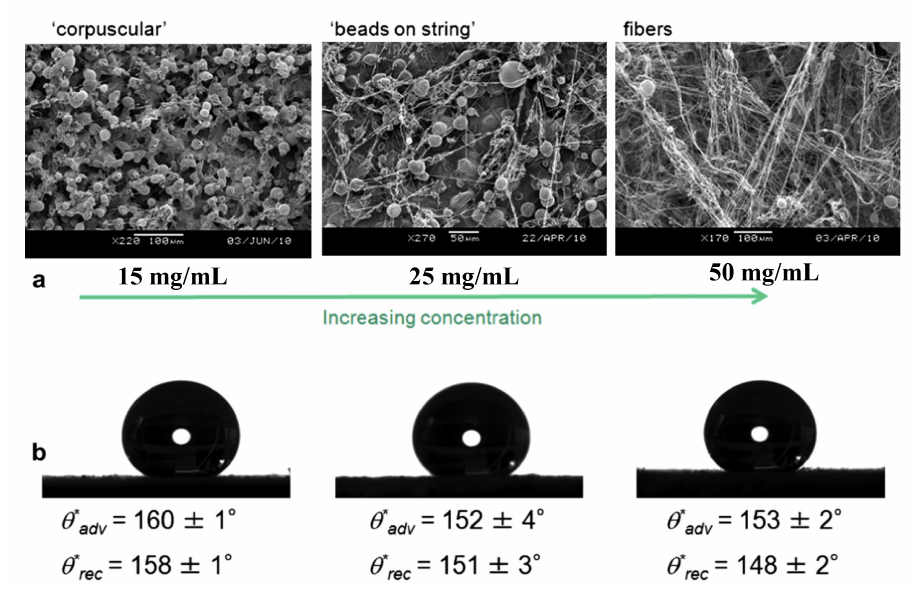
( a ) Scanning electron microscope images of silicon surfaces sprayed with 50/50 wt% PMMA/fluorodecyl POSS blends (B2; M solute concentrations as indicated. ( b ) Droplets of water (15 µ L) on each of the morphologies with corresponding values of apparent advancing θ ∗ Srinivasan et al.